Question: Looking at the figure, what chart type is it?
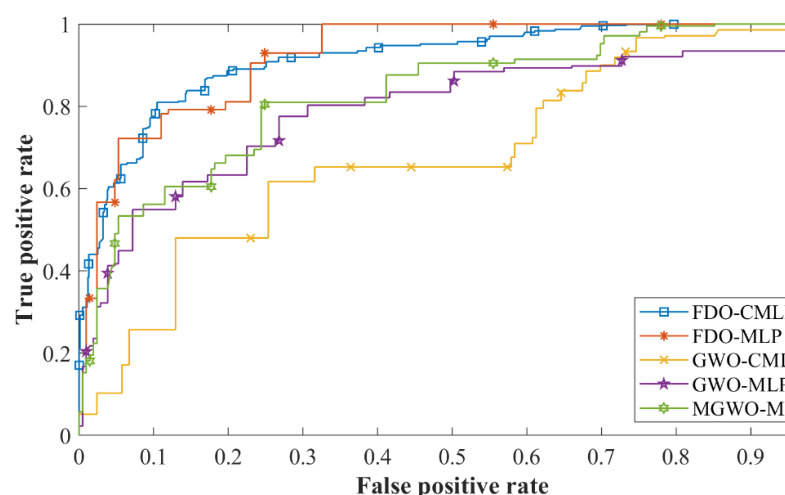
Answer: line